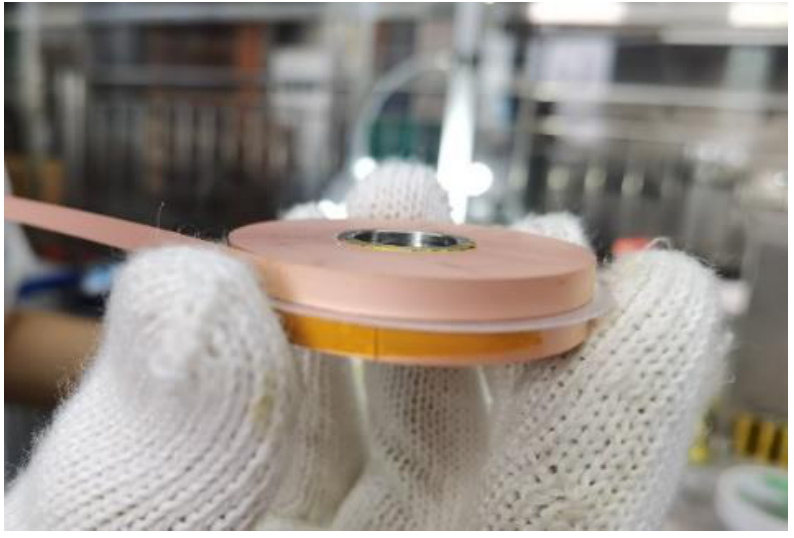
Figure 7. An NI double pancake of Coil 1.